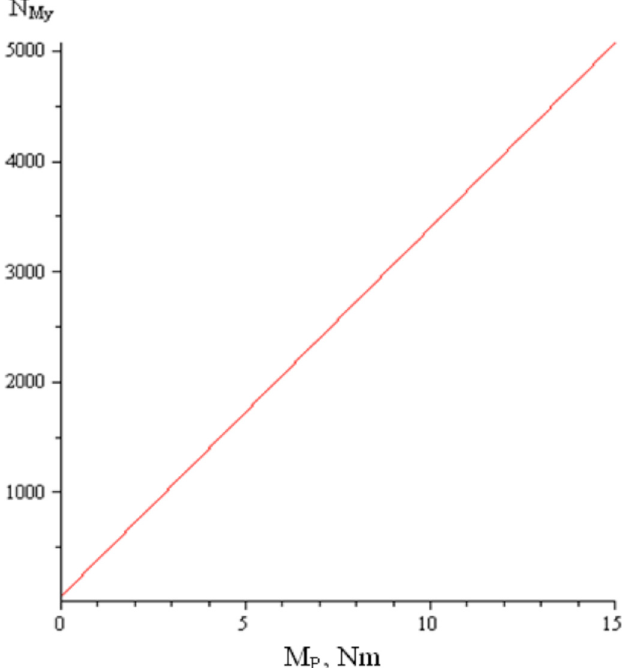
Fig. 4. Description of change in the absolute multiplicative error of the torque MM under the conditions of deviation from the impact value on D J.